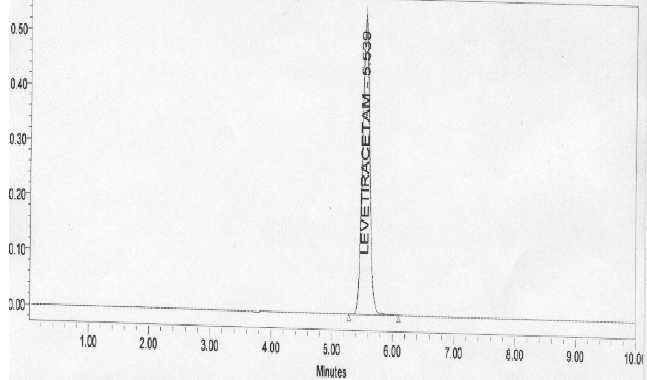
Figure 1. Typical chromatogram of levetiracetam by HPLC